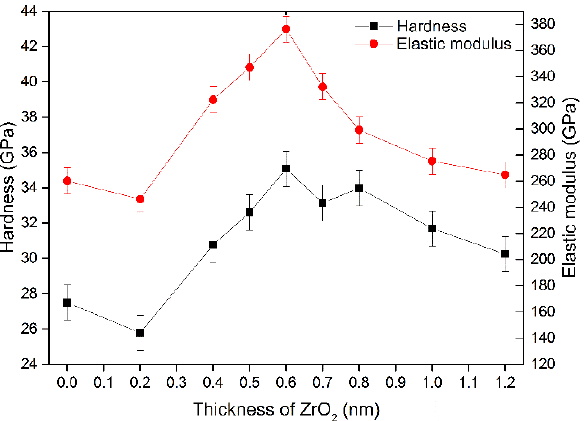
Figure 5. Variation of the hardness and elastic modulus of the (AlCrTiZrMo)N/ZrO 2 nano-multilayered films along with the ZrO 2 layer thickness.